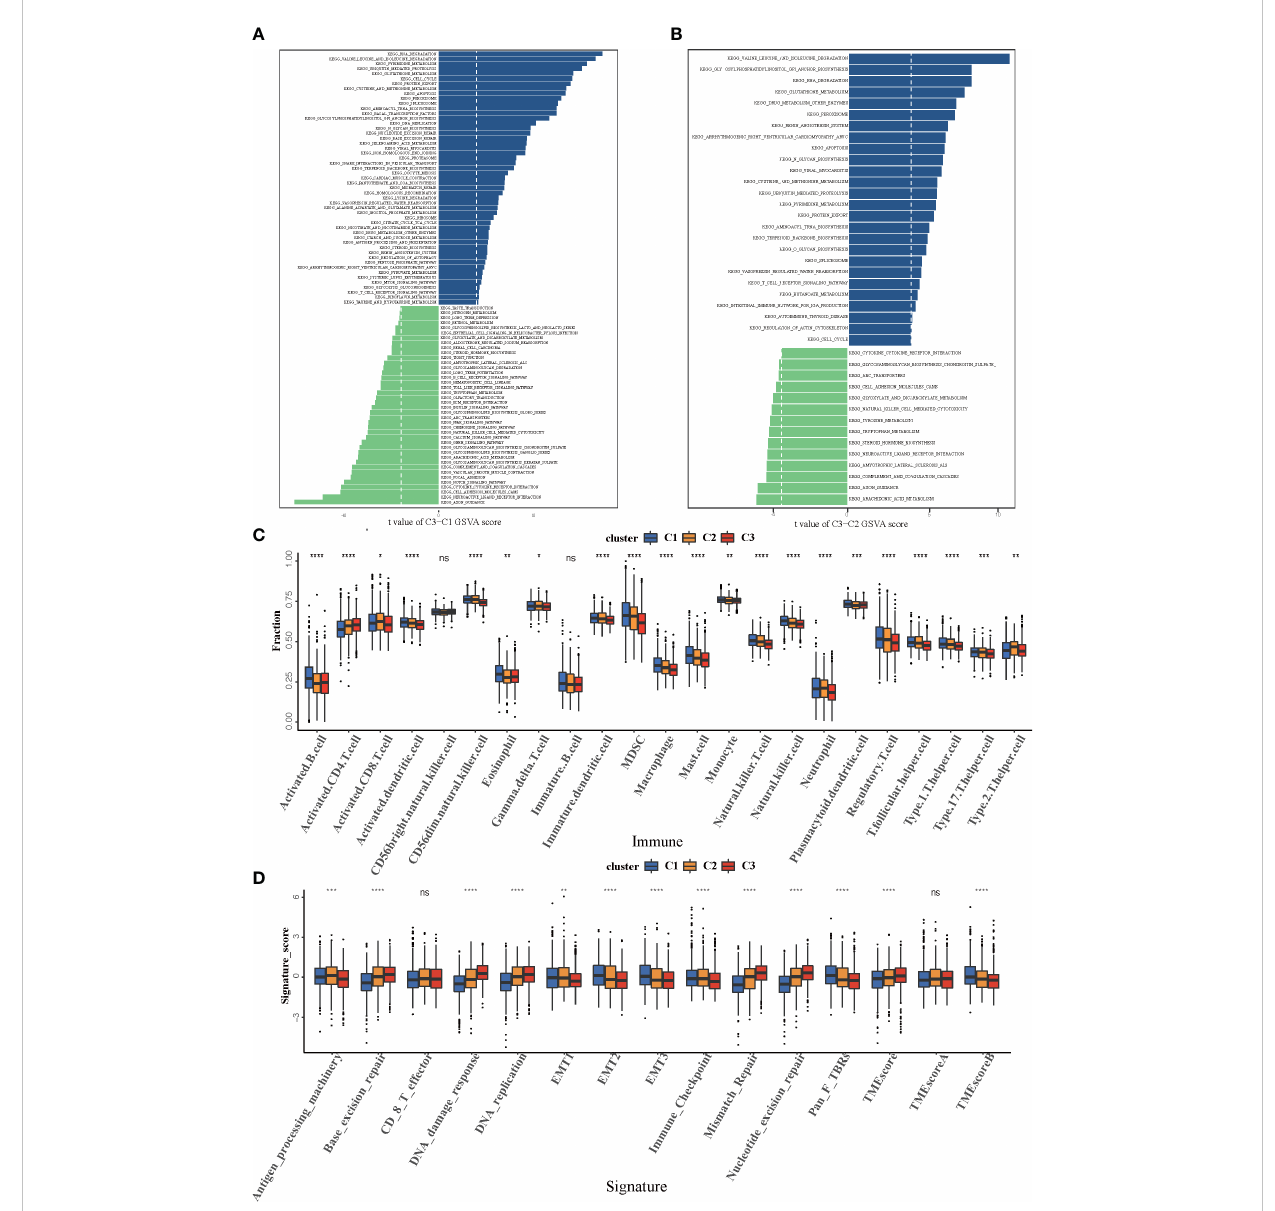
FIGURE 3 Biological and TME in fi ltration characteristics of each cuprotosis pattern. (A, B) Barplot depicting the GSVA score of representative KEGG pathways curated from MSigDB in three cuprotosis patterns. (A) COPcluster C3 vs . COPcluster C1. (B) COPcluster C3 vs . COPcluster C2. (C) The fraction of TME cell in fi ltration of three cuprotosis patterns using the ssGSEA algorithm. The top end, median line, and bottom end of the box represent the 25%, 50%, and 75% value, respectively. The black dots show outliers. The asterisks illustrate the statistical p -value (* p < 0.05, ** p < 0.01, *** p < 0.001, **** p < 0.0001, ns p > 0.05). (D) The fraction of different signatures (immune-relevant signature, mismatch-relevant signature, and stromal-relevant signature) and TMEscore. The line in the box represents the median value. The bottom and top of the boxes are the 25th and 75th percentiles (interquartile range). The whiskers encompass 1.5 times the interquartile range. The asterisks illustrate the statistical p -value (* p < 0.05, ** p < 0.01, *** p < 0.001, **** p < 0.0001, ns p >